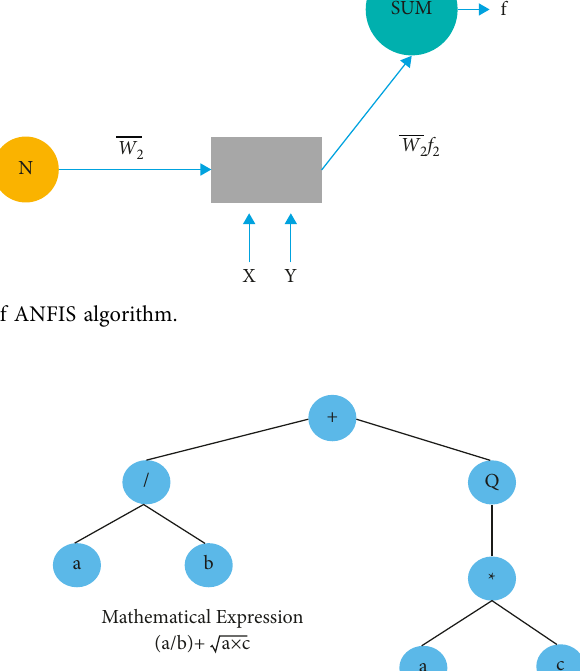
Figure 3: A common form and mathematical expression of two- gene